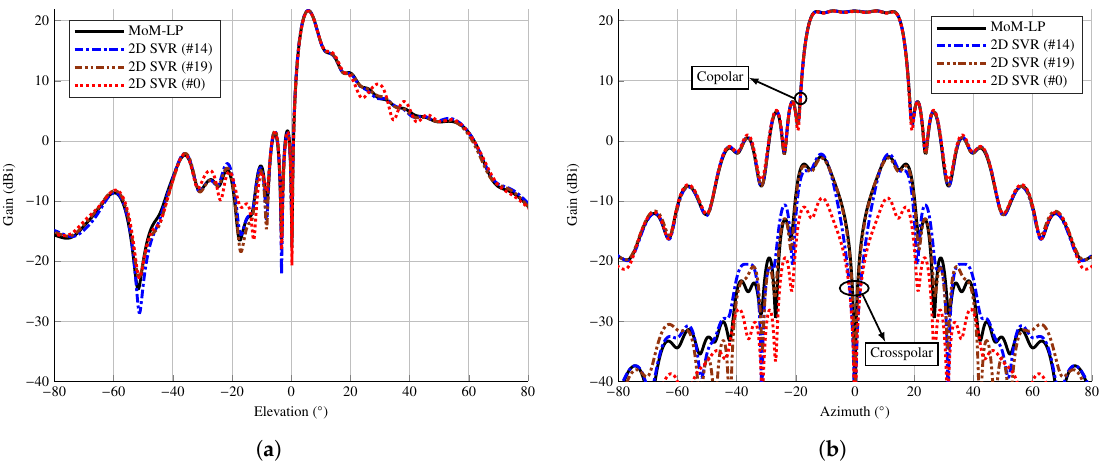
Figure 8. Main cuts for the copolar and crosspolar radiation pattern with ( a ) squared-cosecant pattern in elevation and ( b ) sectored beam in azimuth for polarization V comparing the MoM-LP and SVR